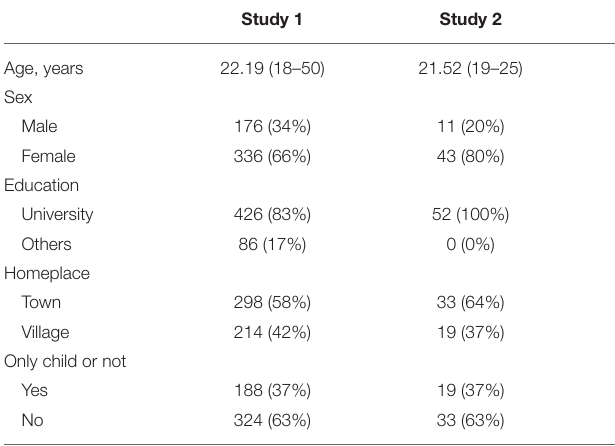
TABLE 1 | Participants